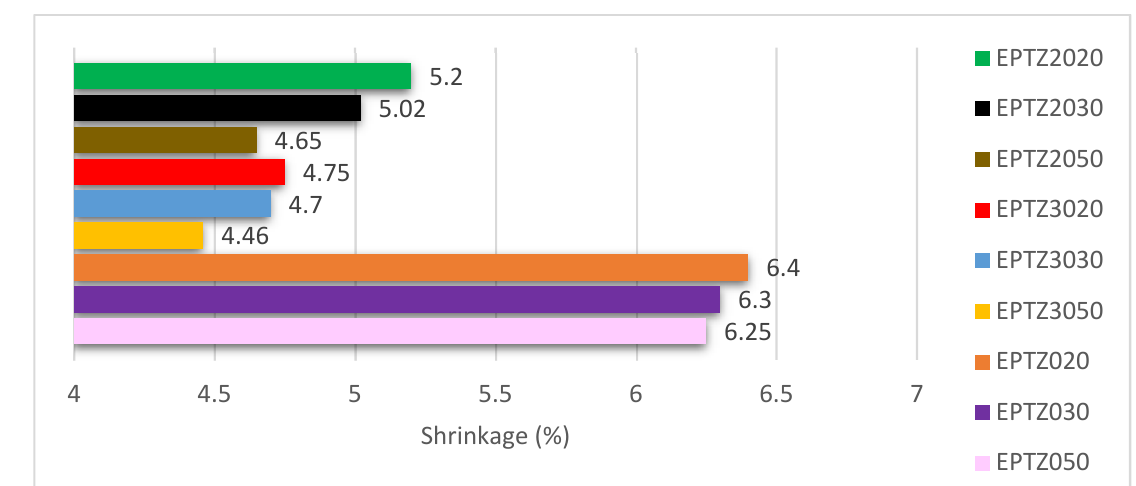
Figure 8. Drying shrinkage for all the constructed mixtures.